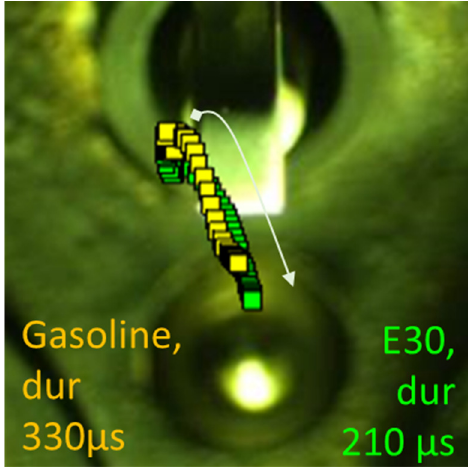
Figure 19. Trajectory of the flame luminosity center for PFS_330 and PFS_210.